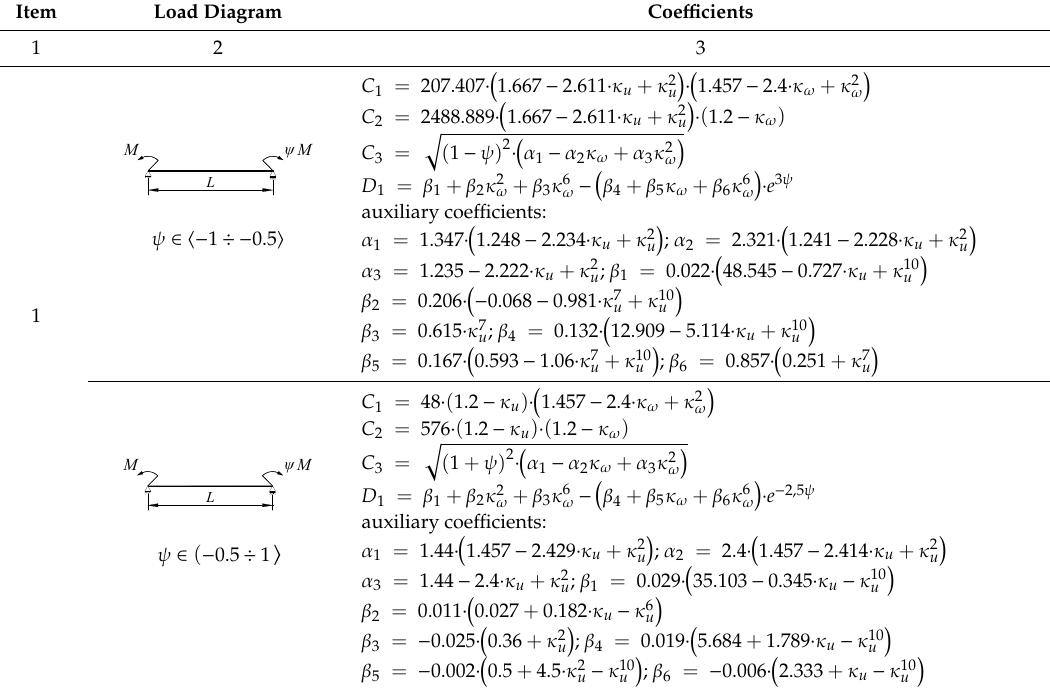
Table 3. Coefficients C 1 , C 2 , C 3 and D 1 for the beam loaded with moments concentrated at supports.